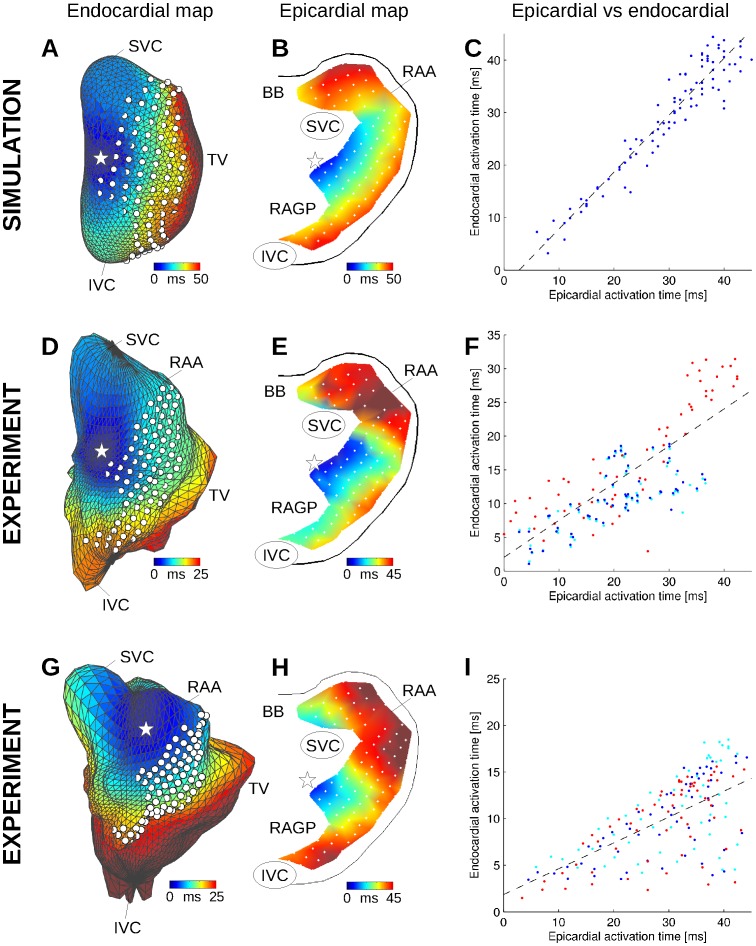
Endo- and epicardial activation maps in the computer model (A–C) and in the experiments (D–I).(A) Color-coded simulated endocardial activation map. White dots represent epicardial electrode positions. The white star denotes the earliest activation point. (B) Simulated epicardial activation map for the same atrial beat. (C) Epi- vs endocardial simulated activation times, along with the linear regression curve (dashed black line). (D) and (G) Experimental endocardial activation maps in two different dogs in control. (E) and (H) Corresponding experimental epicardial activation maps. (F) and (I) Epi- vs endocardial experimental activation times for the three beats (each shown with a different color) that served to identify epicardial plaque location. SVC: superior vena cava; IVC: inferior vena cava; RAA: right atrium appendage; BB: Bachmann’s bundle; RAGP: right atrium ganglionated plexus.